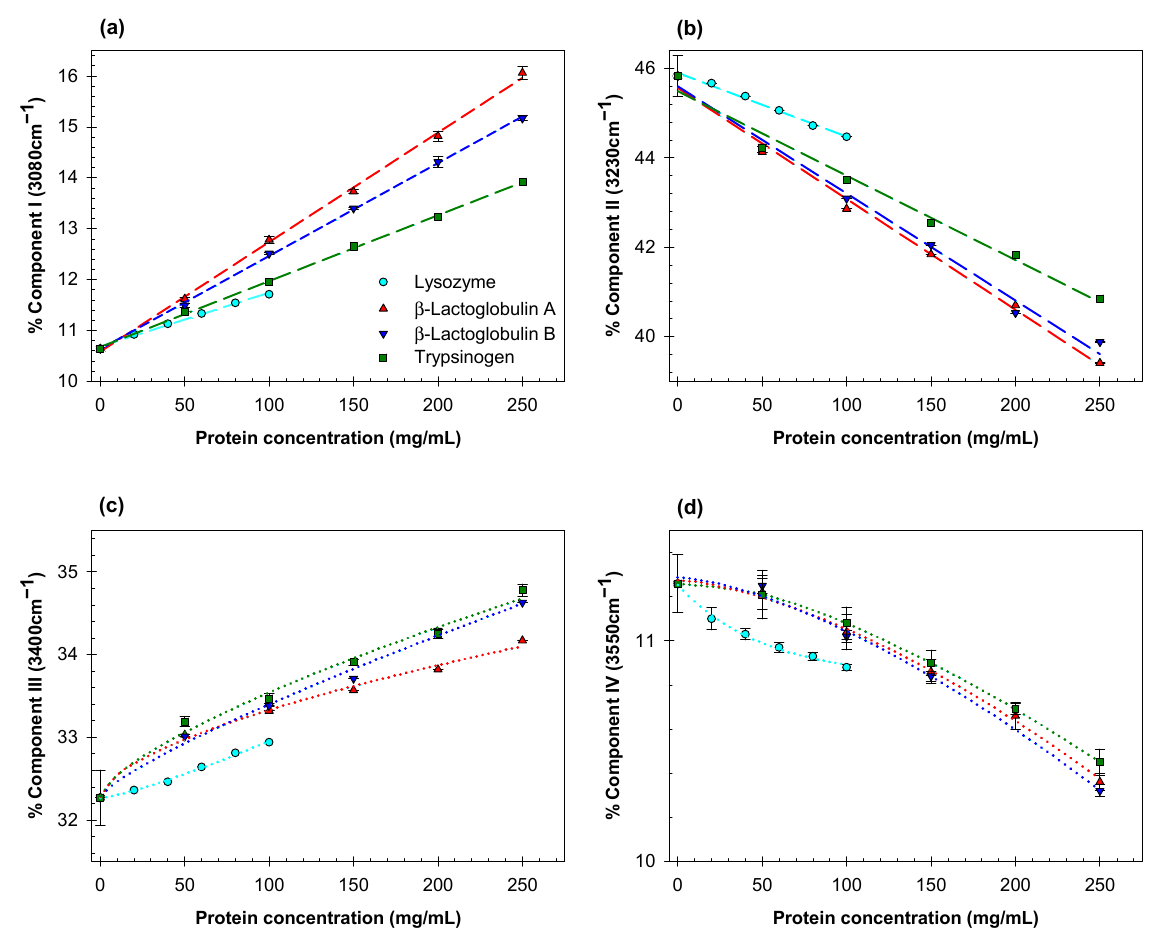
Figure 3. Concentration dependences of the relative contributions of the Gaussian components I ( a ), II ( b ), III ( c ), and IV ( d ) for chicken egg lysozyme (cyan circles), β -lactoglobulins A (red triangles) and B (blue inverted triangles), and trypsinogen (green squares).